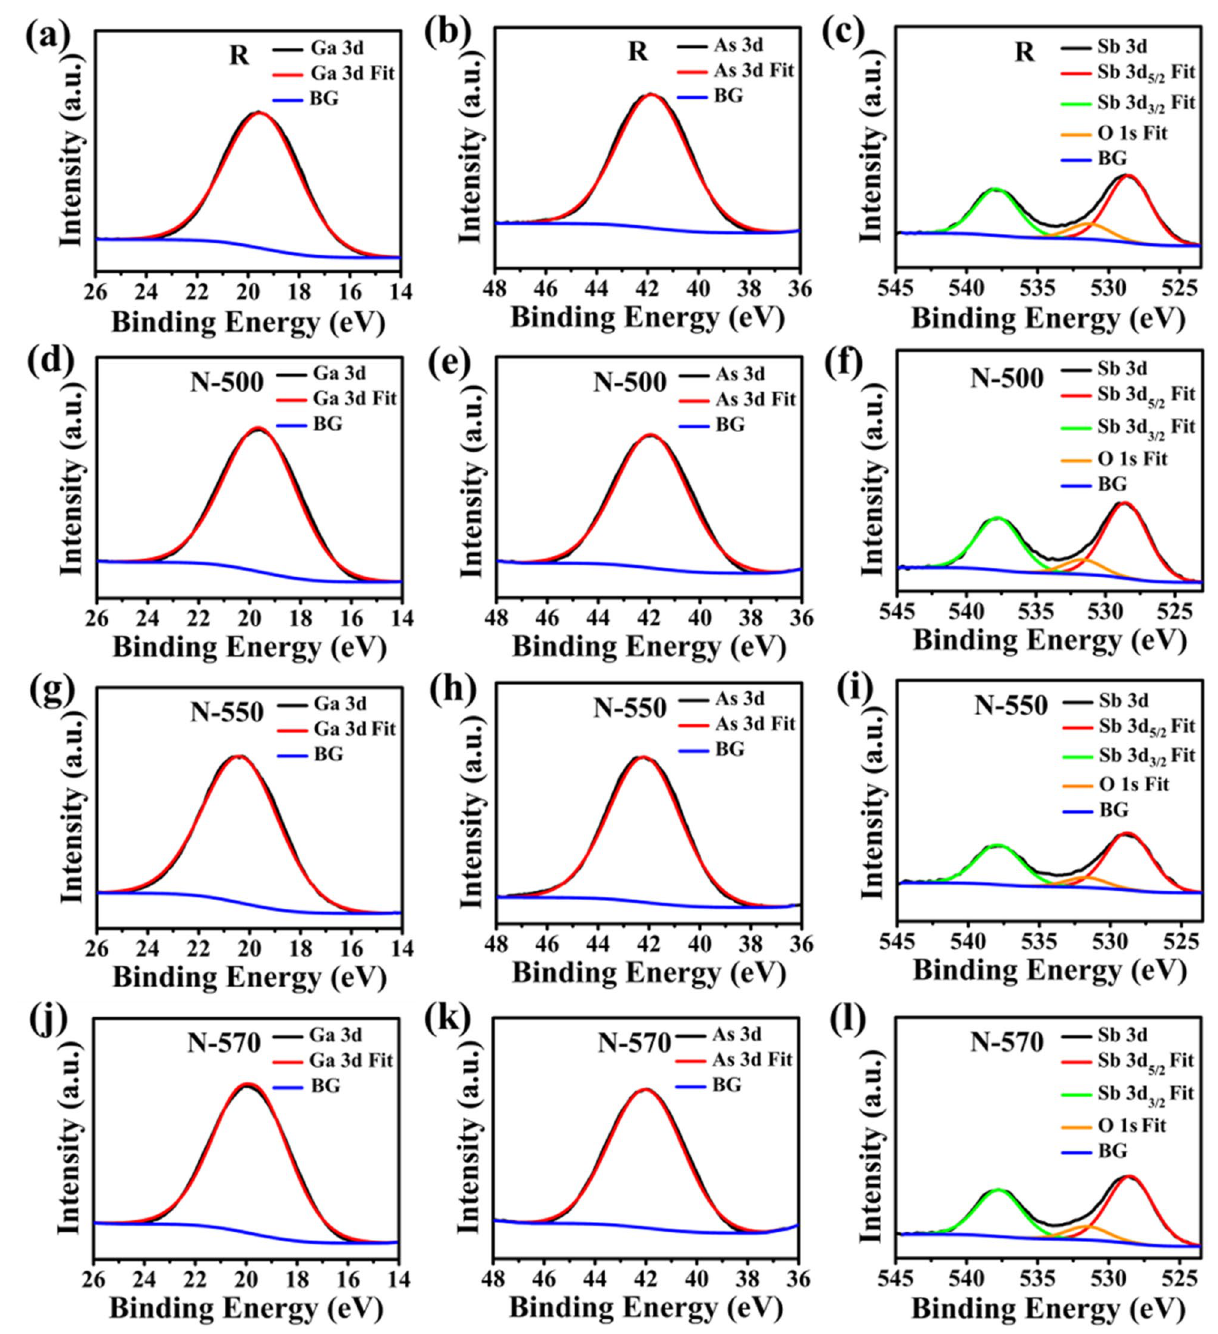
Figure 1. XPS spectra for ( a , d , g , j ) Ga 3d, ( b , e , h , k ) As 3d, ( c , f , i , l ) Sb 3d core levels of (1st row) R, (2nd row) N-500, (3rd row) N-550, and (4th row) N-570 samples,